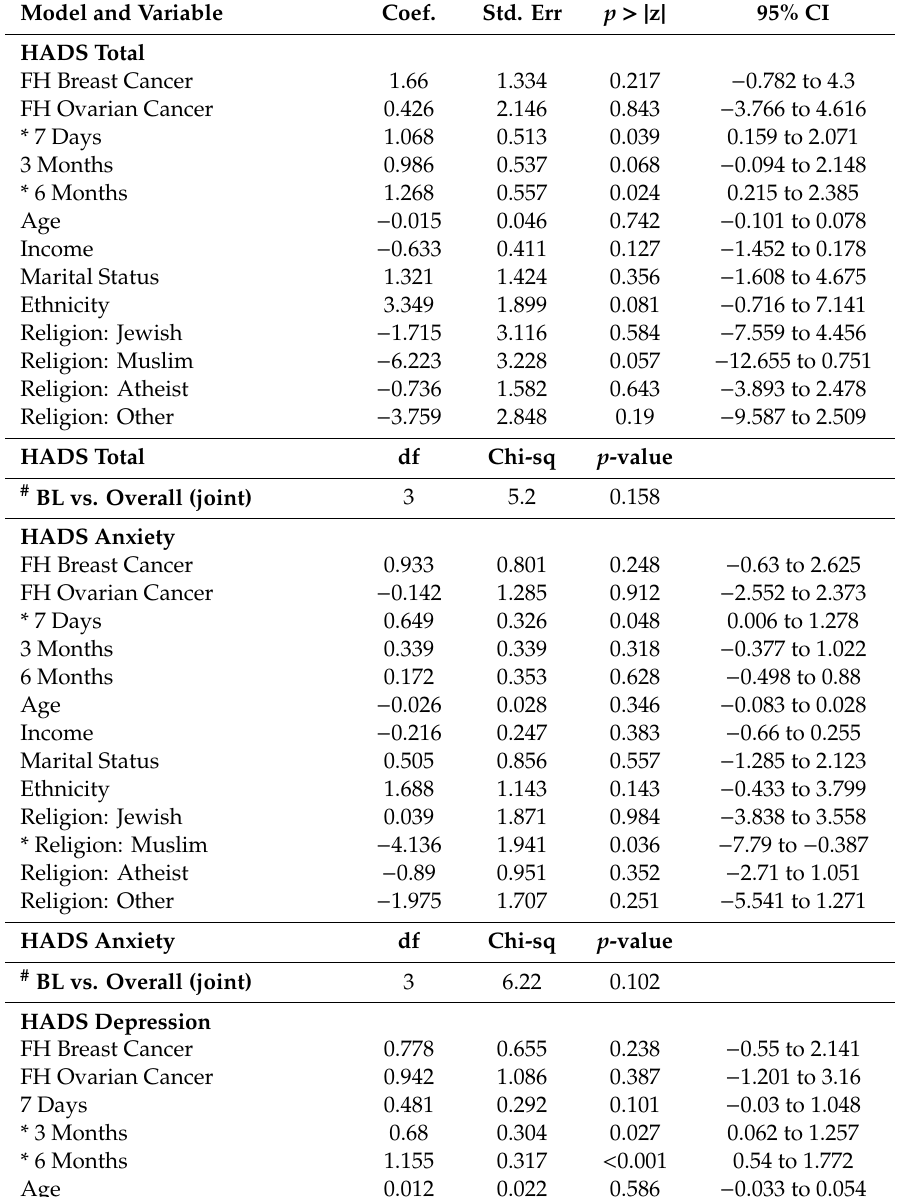
Table 5. Linear random-e ff ects mixed models and overall contrast tests for study outcomes.